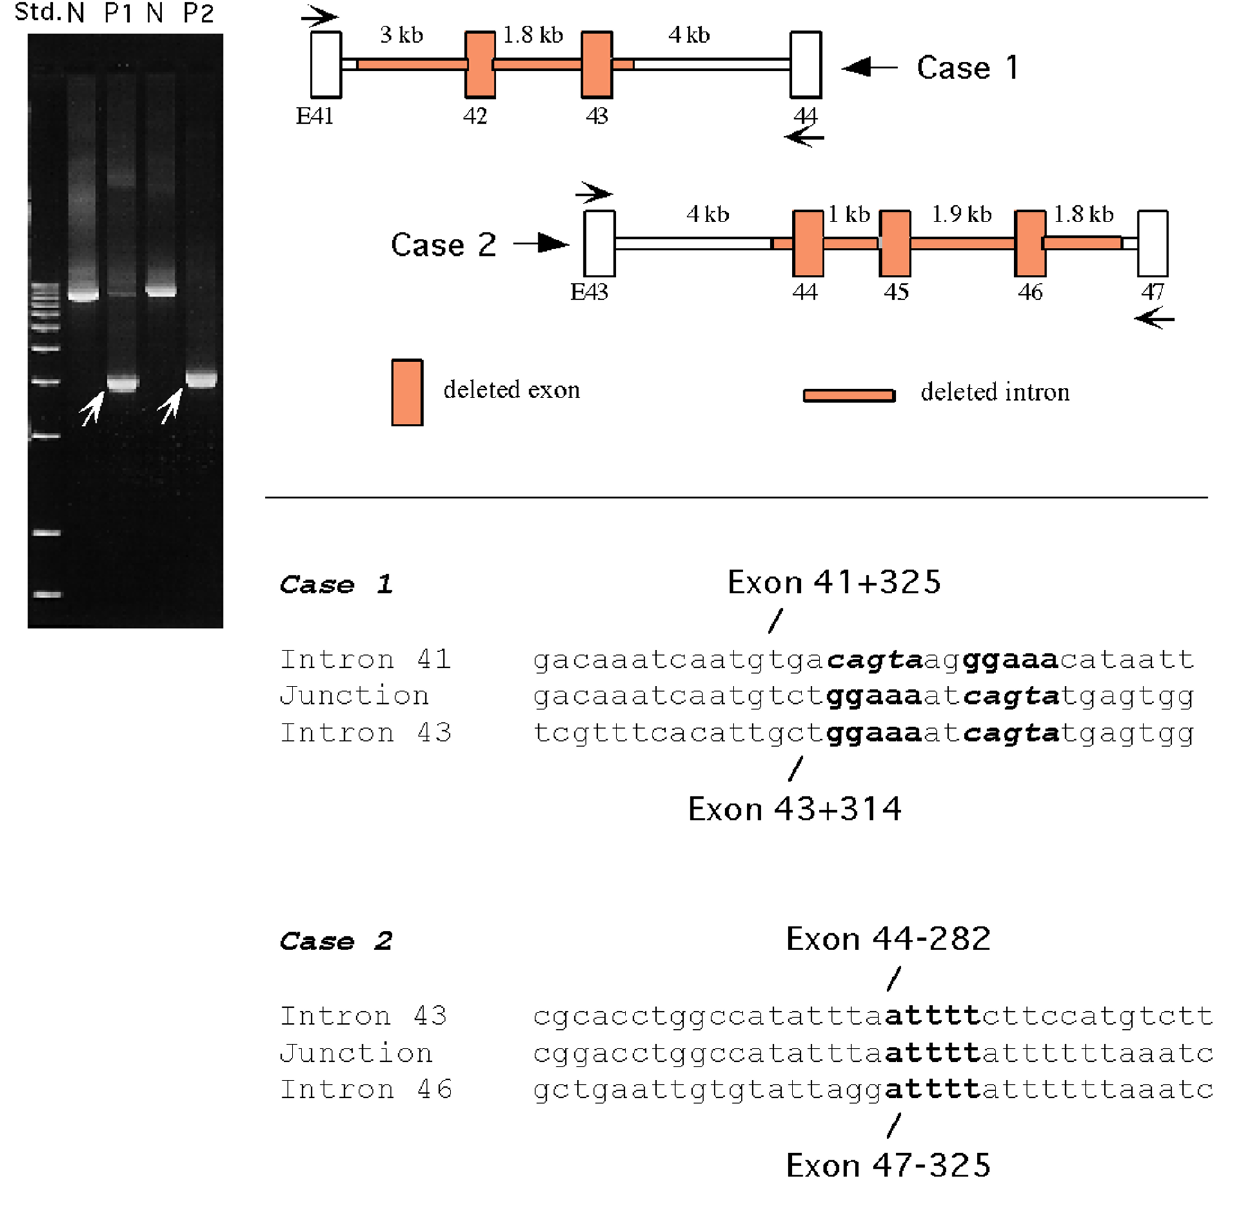
Figure 2 Left: Long PCR analysis of genomic DNA indicates about 5 kb deletions in both patients PI and P2. Lane 1 (Std) is a 1 kb ladder. Arrows point to the abnormal fragments generated by the genomic deletions. Sample N is amplified from a normal control. Right: Schematic representation of the deletion regions of the genomic DNA (shaded). Bottom: Sequence analysis of junction fragments amplified by PCR reveal identical pentamers (bold). In Case 1, the nucleotide (t) at position +325 in intron 41 is joined to the nucleotide (c) in position +314 in intron 43. In Case 2, the breakage and rejoining occurred within the pentamer (atttt) at positions -282 to -278 of intron 43 and positions -325 to -321 of intron